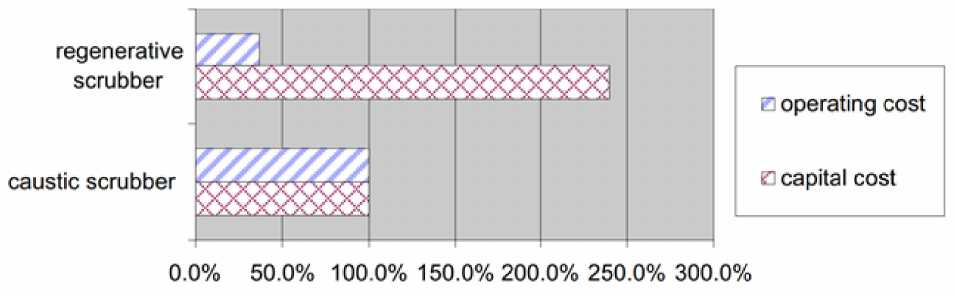
Figure 28. Economic implication of web scrubbing systems (Adapted from Weaver